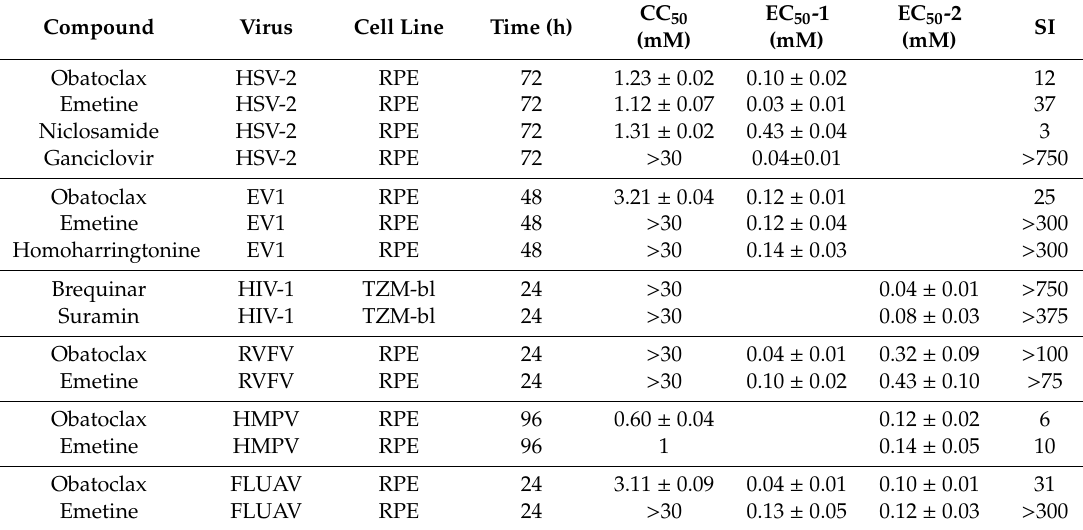
Table 1. The half-maximal cytotoxic concentration (CC 50 ), the half-maximal e ff ective concentration 1 (EC 50 -1) calculated using the CTG or CTxG assays, EC 50 -2 calculated using reporter protein expression, and the minimal selectivity indexes (SIs = CC 50 / EC 50 ) for selected broad-spectrum antivirals. The measurements were repeated three